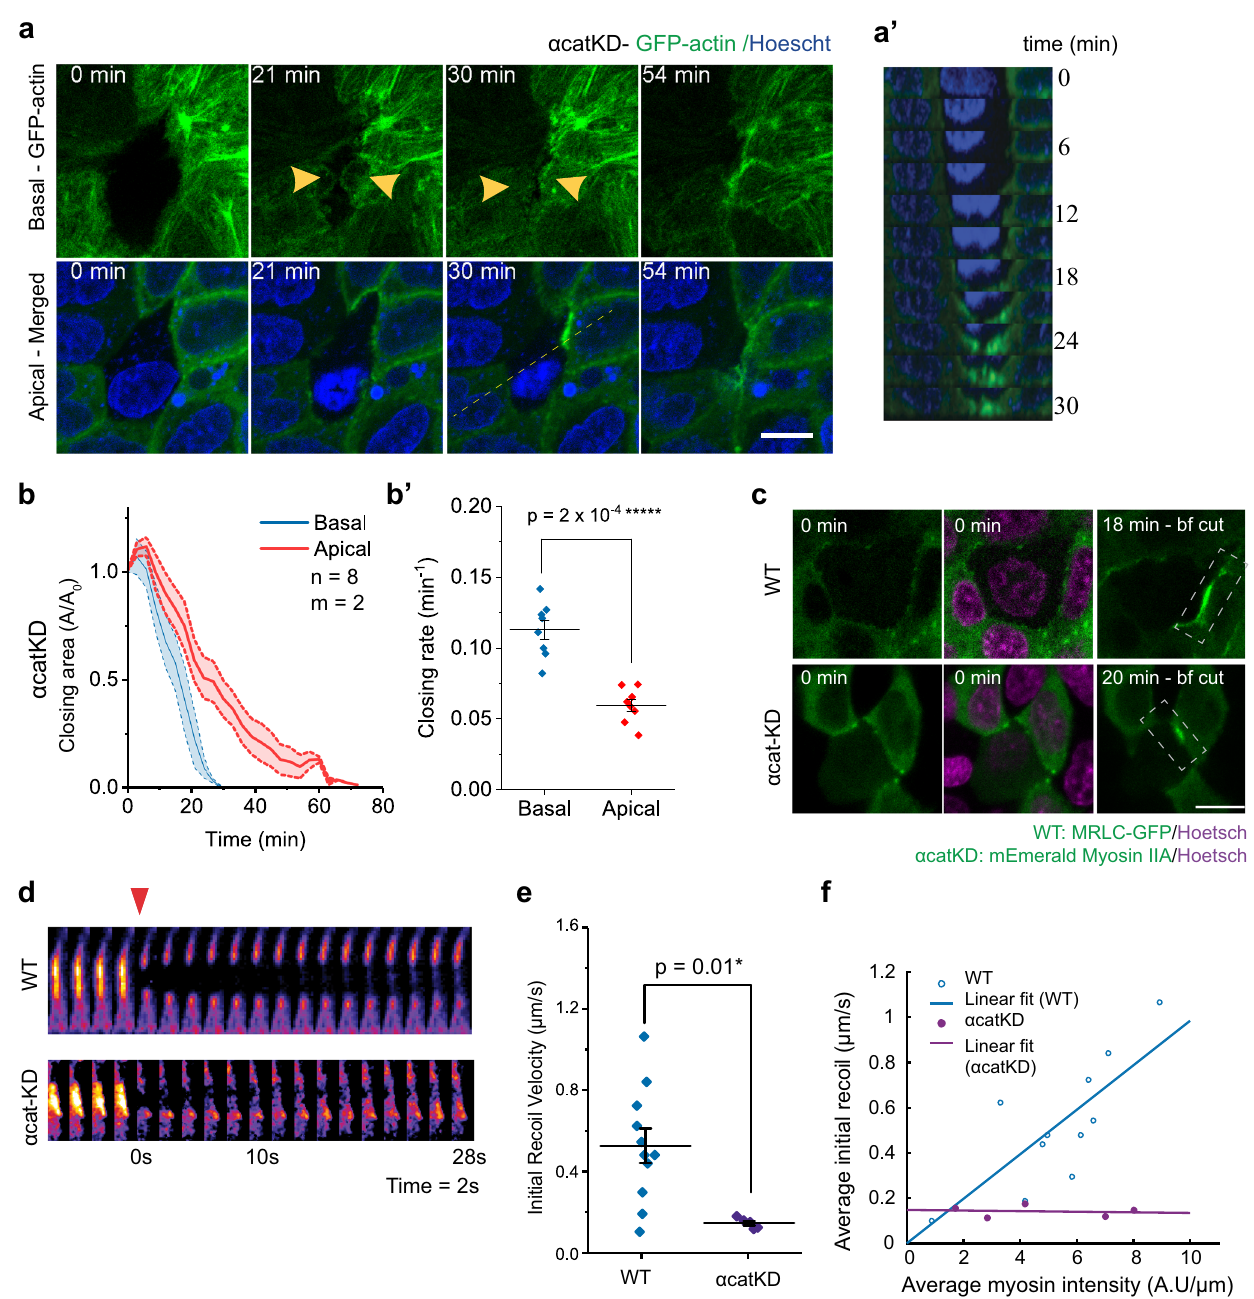
Fig. 4 Reduction of cell – cell junction (CCJ) strength impairs purse-string formation and makes extrusion depend on lamellipodia protrusion. a – a ’ Time-lapse imaging of α cat- knocked-down MDCK cells ( α -catKD-GFP-actin) expressing GFP-actin. The cell in the middle undergoes extrusion. a Top panels: basal plane, bottom panels: apical plane ( + 4 µ m above basal plane). Scale bar = 10 µ m. a ’ Side view along the dashed line, reconstructed from a Z- stack of 7 µ m (0.5 µ m slice). b Average relative closing area of basal versus apical planes (de fi ned as + 4 µ m from the basal plane), normalized at t = 0 min for α -catKD-GFP-actin MDCK cells. Shaded area: SEM. n = 8 indicates number of extrusion from m = 2 independent experiments. b ’ Closing rate derived by extracting the tangent of initial phase of the area closing curve. Middle lines: mean. Error bars: SEM. Paired t -tests (two-tailed) were performed. c – f Laser ablation at CCJ during extrusion on WT MDCK cells expressing GFP-MRLC and α catKD MDCK cells expressing m-Emerald Myosin-IIA. N = 11 for WT and N = 5 for α catKD indicate number of laser ablation experiments. ( c ) Top view of myosin accumulation at CCJ. t = 0 min refers to the initiation of laser-induced extrusion. Images in the last panel (bf cut before cut) are at the time point laser ablation was performed on the cable. Dashed rectangles indicate the junction where laser ablation was performed. d Evolution of myosin signal from the rectangular area in c before and after laser ablation of cell – cell junctions. Enhanced myosin recruitment is shown in FIRE LUT. Arrowhead indicated the point at which laser ablation is performed. e Initial recoil velocity — which re fl ect junction tension — after ablation for WT versus α catKD. Middle lines: mean. Error bars: SEM. Unpaired t -test (two-sided) was performed. Number of laser ablation experiments WT: n = 11 and α catKD: n = 5. f Average initial recoil velocity as a function of average myosin accumulation prior to laser ablation. Middle lines: mean. Error bars: SEM. Linear regression was performed to fi t. Source data for b – f are provided as a Source Data fi